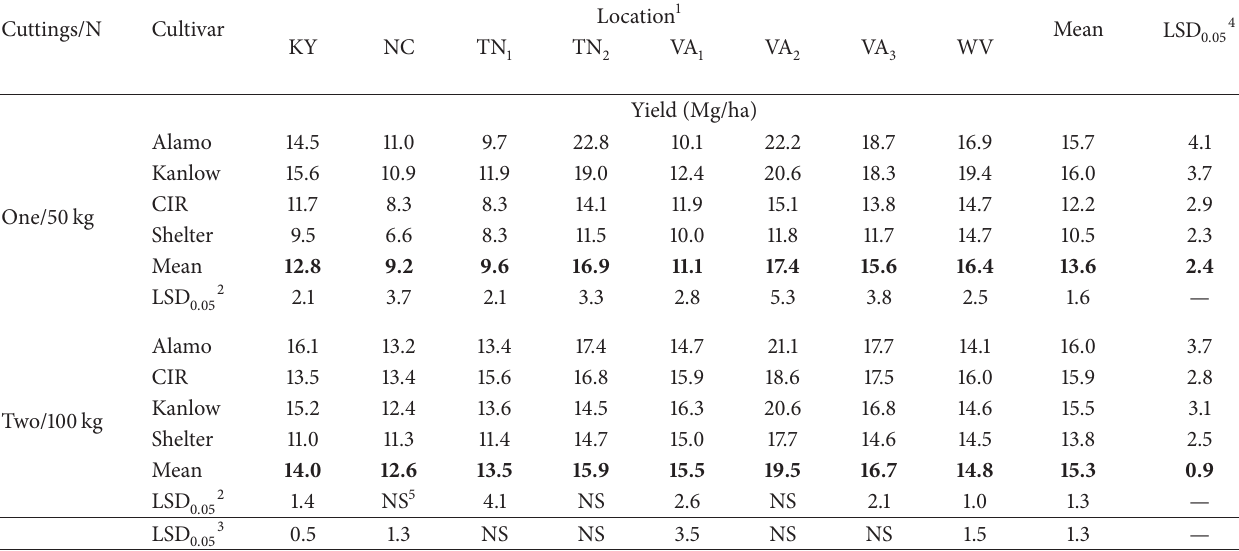
1 Locations: KY (Princeton), NC (Raleigh), TN LSD for comparison of cultivars within a management and location. 3 LSD for comparison of means within location. 4 LSD for comparison of locations within each management and cultivar. 5 NS: not significant.